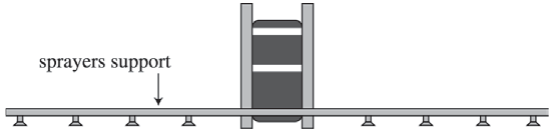
Figure 1. Schematic representation of the agricultural